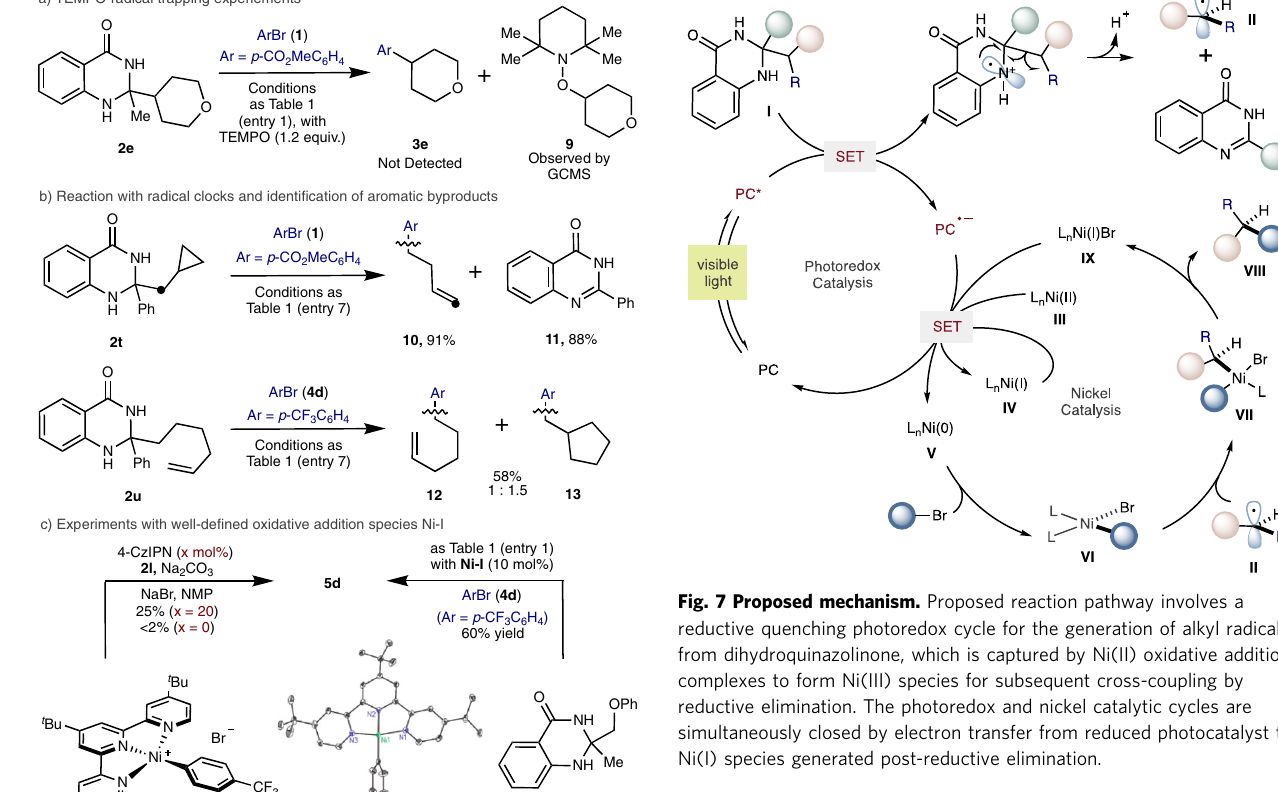
Cambridge Crystallographic Data Centre. Any further relevant data are available from the authors on request.